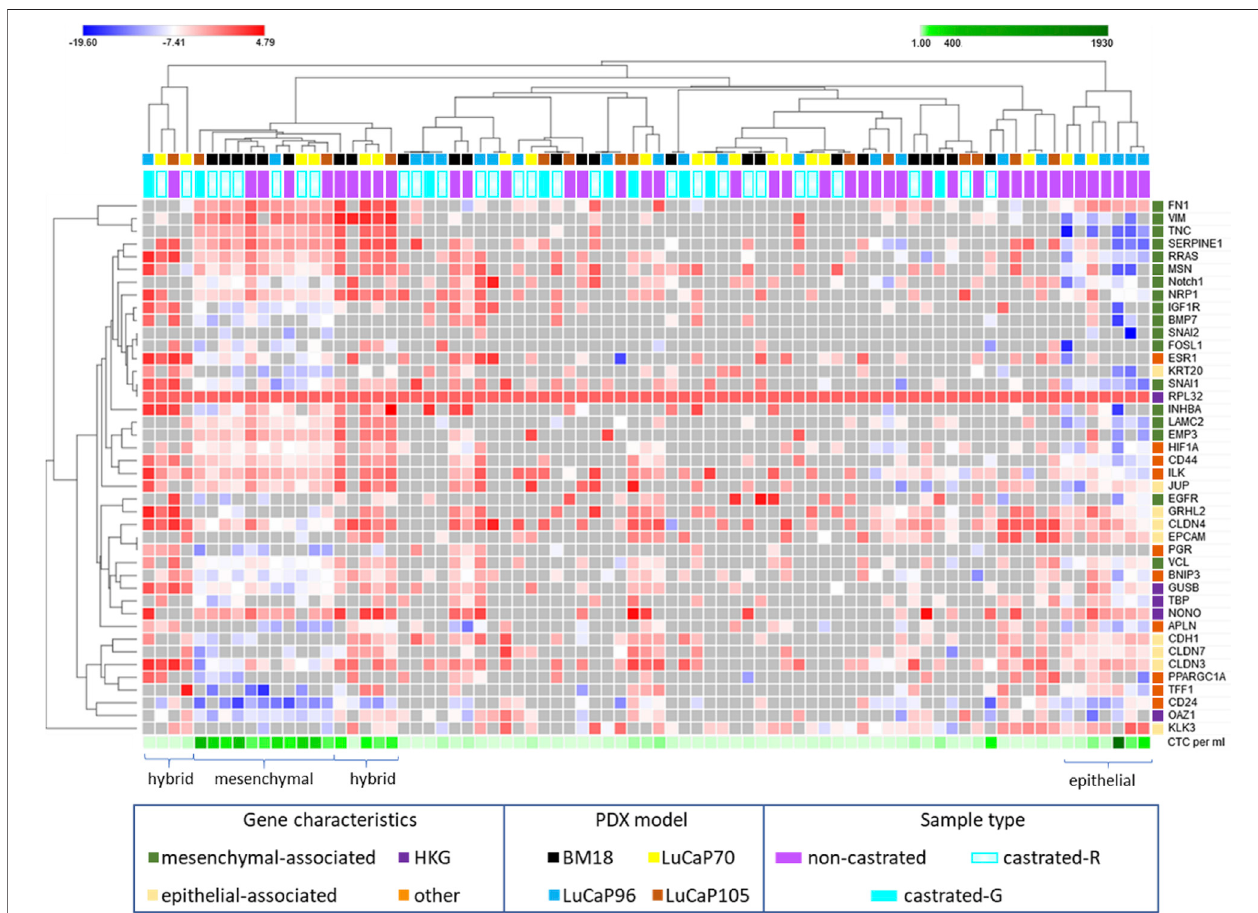
FIGURE6| Heatmap ofRPL32normalised Δ Ct valuesfor 42genesfollowingRT-qPCRanalysisofblood samplesfromcastratedand non-castratedPDX-bearing mice. The data for non-castrated mice was reported previously (Hassan et al., 2021b). Hierarchical unsupervised clustering was performed using one minus Pearson correlationandglobalnormalisation.Brightred denoteshighexpression andbrightbluedenoteslowexpressionofindividualgenes.Greyrepresentsnodetection. Each row corresponds to a gene and each column corresponds to a blood sample. Four clusters, epithelial, hybrid (x2), and mesenchymal associated, are indicated. Whether castrated mice had regressed (castrated-R) or growing (castrated-G) tumours is indicated.